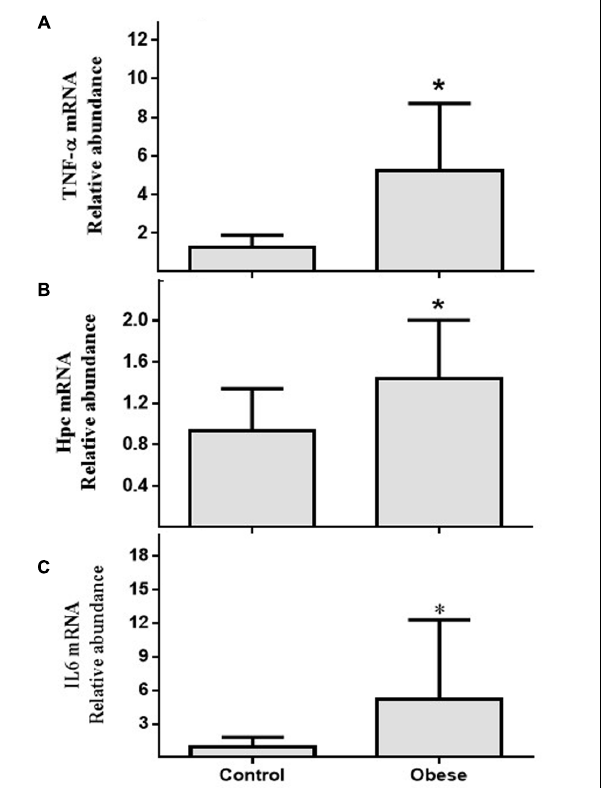
FIGURE 1 | mRNA relative abundance of genes related to inflammation and Fe metabolism in PBMCs. (A) TNF- α ( p = 0.018); (B) Hpc ( p = 0.03); (C) IL6 ( p = 0.02). Values are median and range interquartile. Mann–Whitney test. ∗ Indicates significant difference.